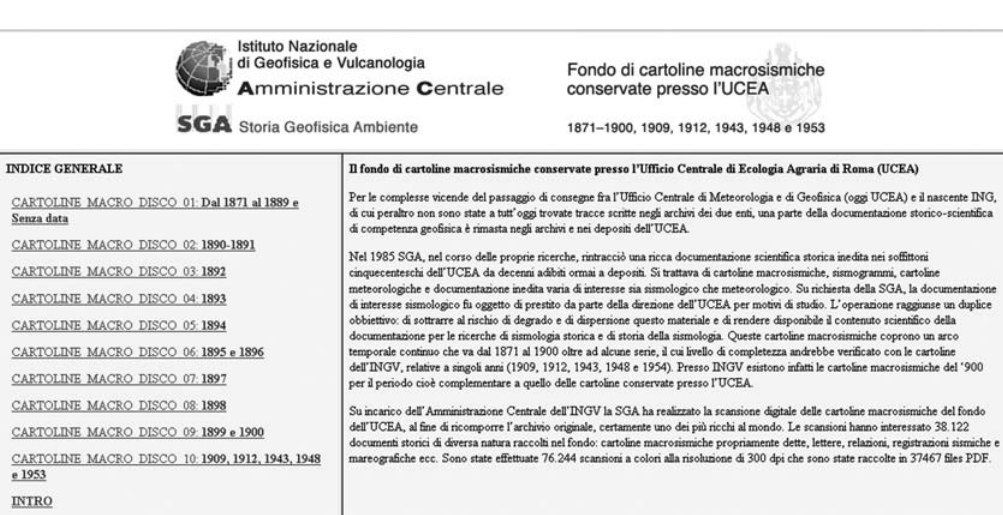
Fig. 20. Initial HTML page (Home) for the chronological consultation of the digital of the macroseismic ques- tionnaires. In the top frame the project credits are given; in the one on the left there is a general index with the links for the navigation within the Archive; in the one on the right-hand side, the history of the Archive is con- cisely told, from its birth to the digital scanning in